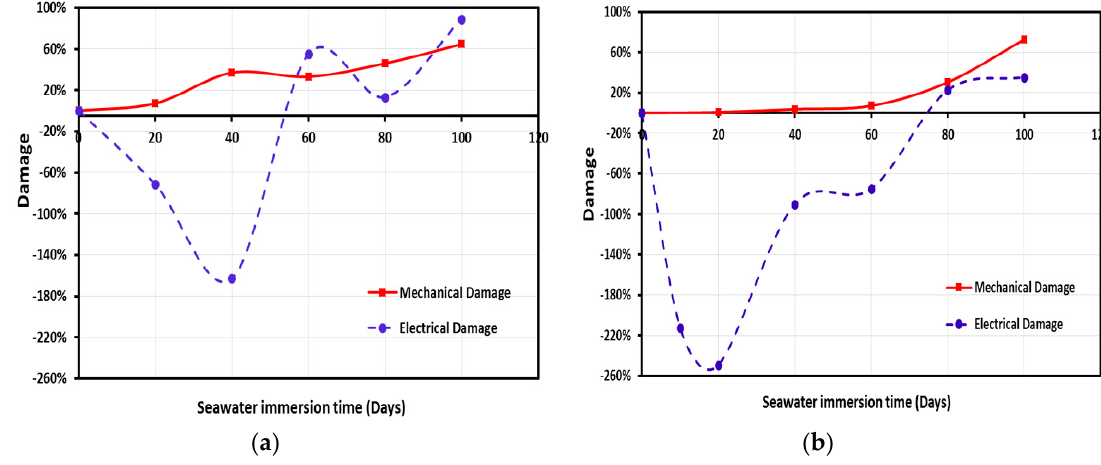
Figure 14. The mechanical and electrical damage for MWCNTs/GFRP composite vs. immersion time at temperatures ( a ) 22 °C and ( b ) 45 °C.